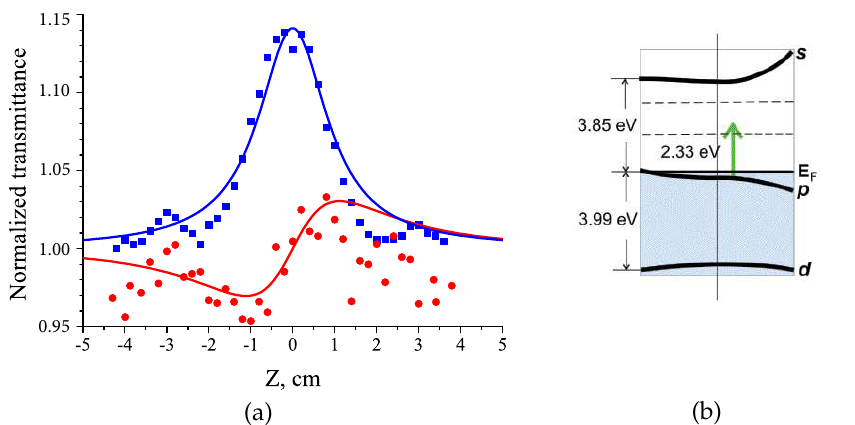
Figure 12. Normalized open-aperture (blue squares) and limited-aperture (red circles) Z-scan traces of Ag-nanocomposite at 532 nm excitation ( τ p = 20 ns, f = 0.5 Hz, I 0 = 5.11 MW/cm 2 ). The lines are